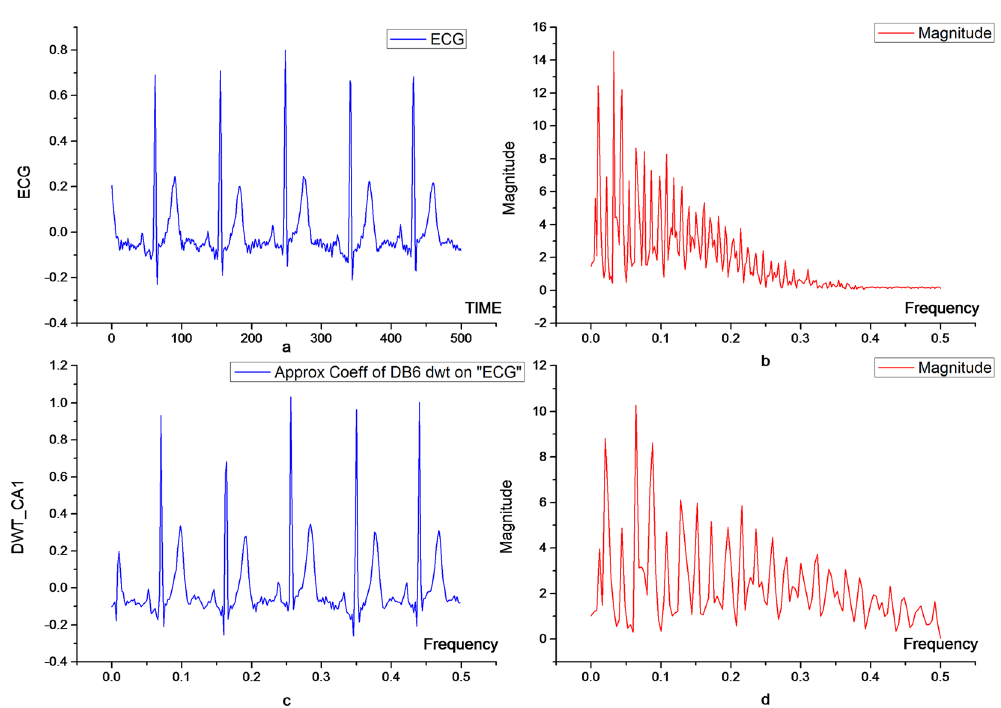
Figure 5. Low frequency component and frequency characteristics of ECG signal after DB6